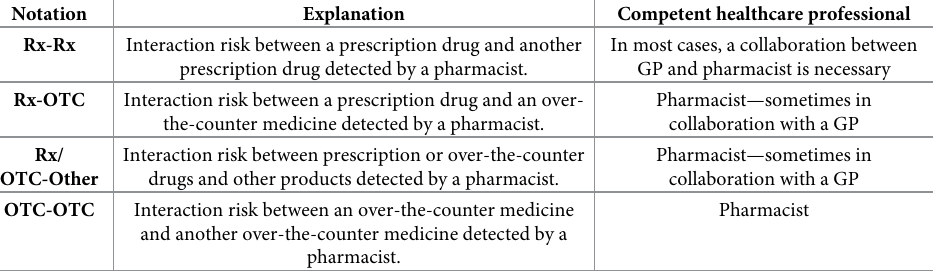
Table 2. Grouping of interactions based on the prescribing and dispensing category of the medicine, and on which healthcare professional is competent to provide the necessary intervention and a complete